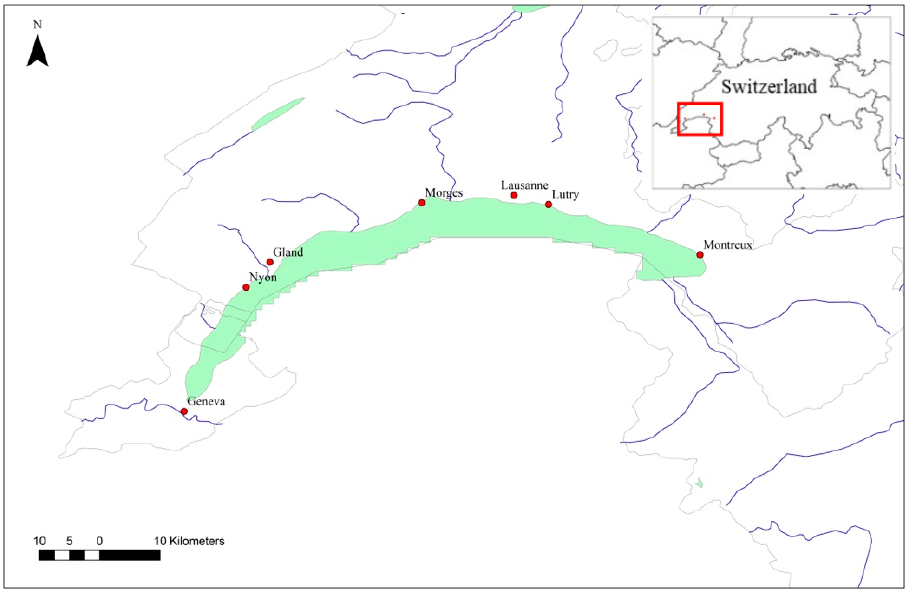
Figure 1. The study site depicting the region between Lutry and Gland in which the in-person questionnaires were administered with lake users.